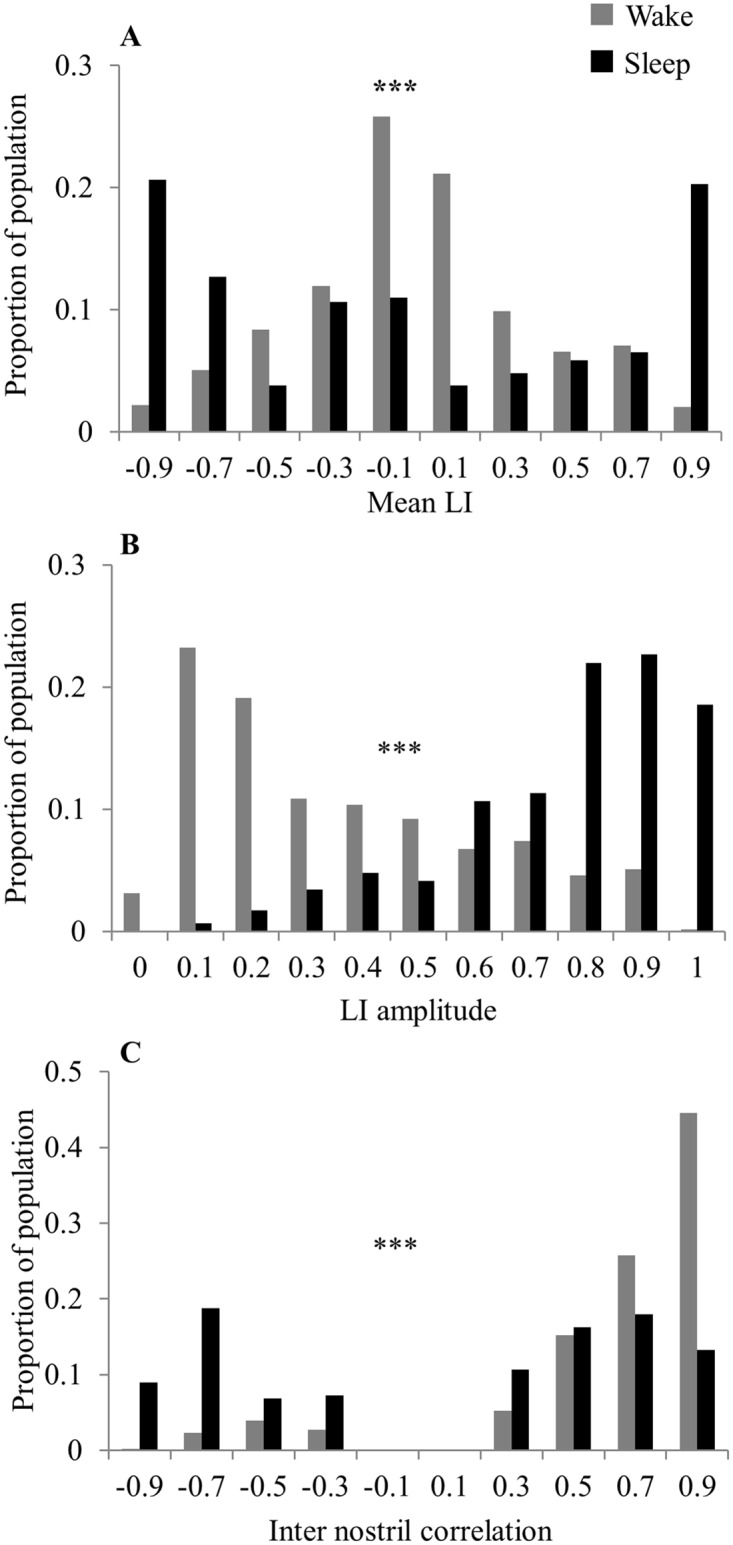
The difference between sleep and wake was evident in 1-hour windows.Distribution of nasal cycle characteristics calculated in 1-hour non-overlapping windows. (A) Mean Laterality Index. (B) Amplitude of laterality index. (C) Inter nostril correlation. This figure implies that the results did not reflect an averaging artifact.